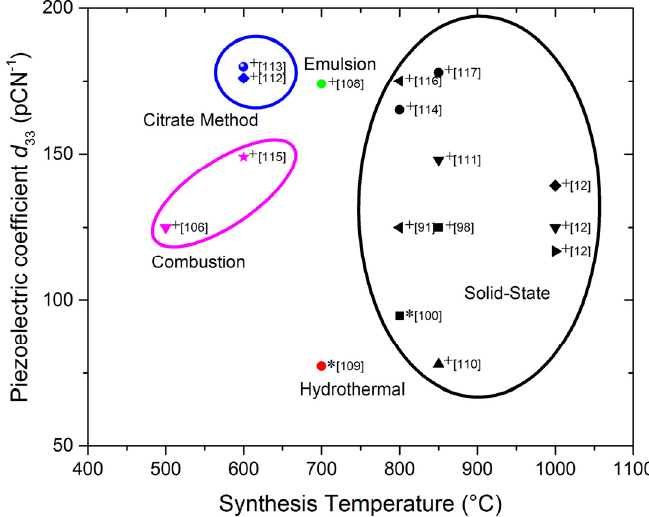
Figure 10. Piezoelectric coefficient d 33 vs . synthesis temperature for the different methods of BNT ‐ BT ceramics preparation, extracted from references in Table 2. ( * Pure BNT. + BNT ‐ based solid solution).